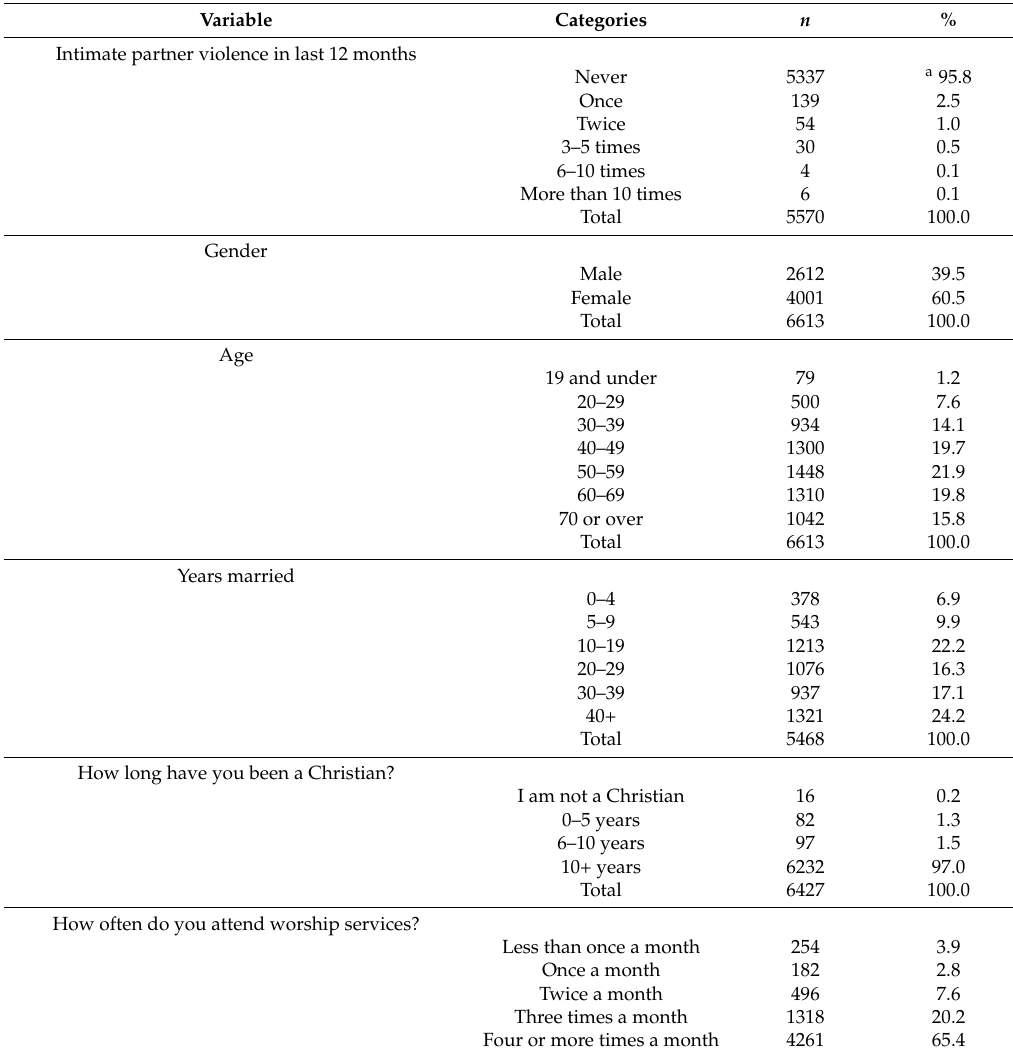
Table 2. A summary of the categorical and ordinal